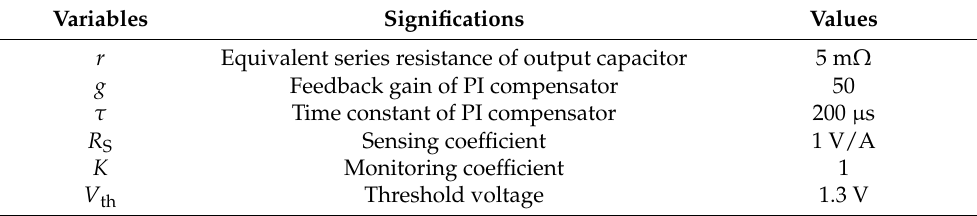
Table 3. Fixed-circuit parameters of the improved CC-COT-controlled buck converter for comparison.